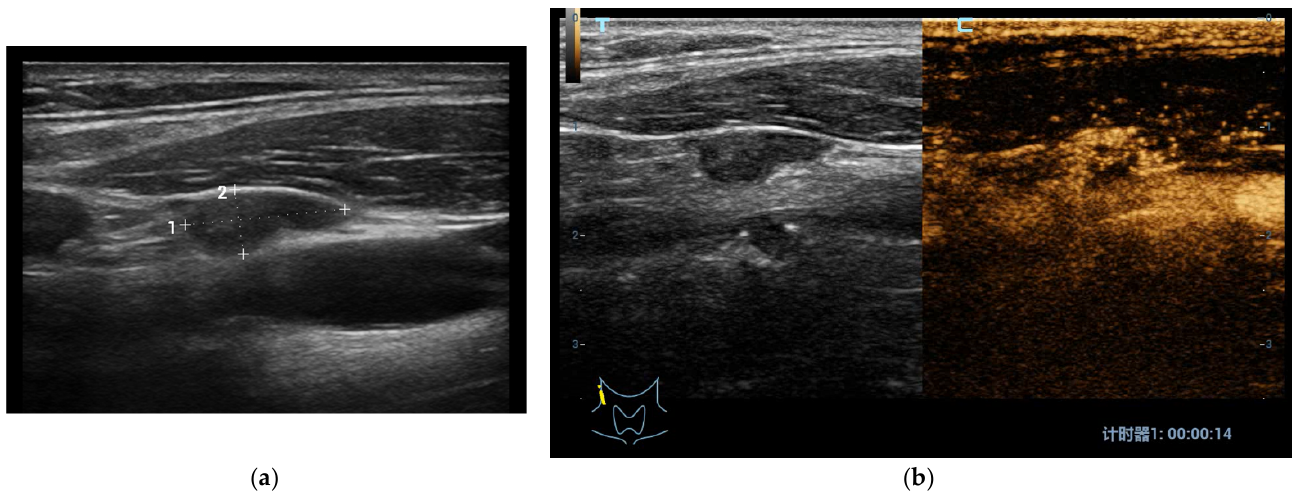
Figure 2. ( a ) At B-mode US in Patient with papillary thyroid carcinoma, a laterocervical node showed irregular shape, hypoechoic aspect and regular margins with no internal microcalcifications or cystic changes (low metastatic risk); ( b ) At CEUS, the laterocervical node presented rich heterogeneous and centripetal vascularization (high metastatic risk). The histological examination confirmed that it was a metastatic node of a papillary thyroid cancer.